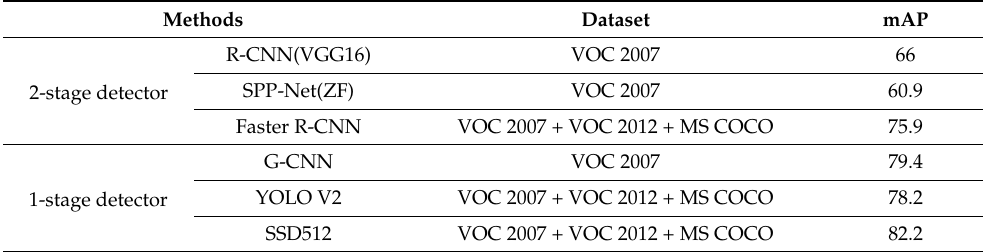
Table 1. The mAP comparison of object detection methods by PASCAL VOC and MS